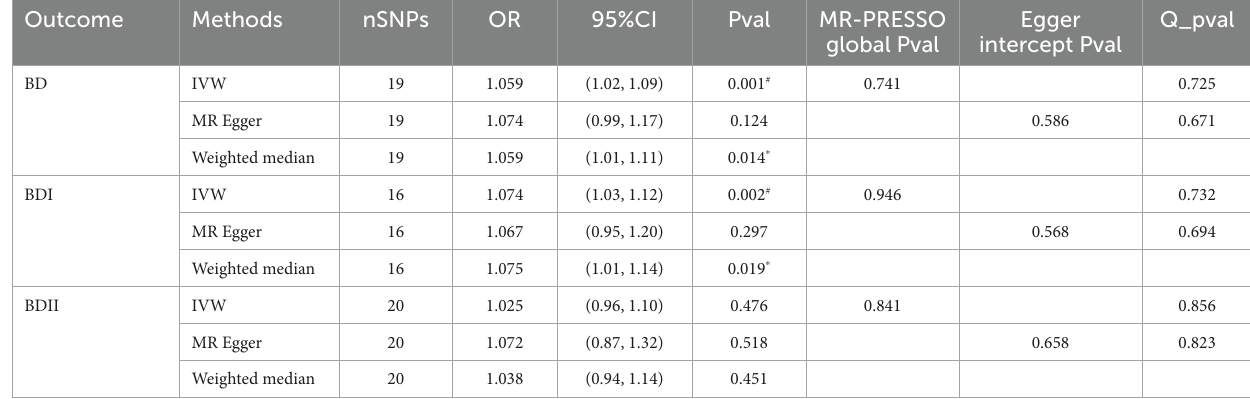
TABLE 3 Causal relations of psychiatric disorders with